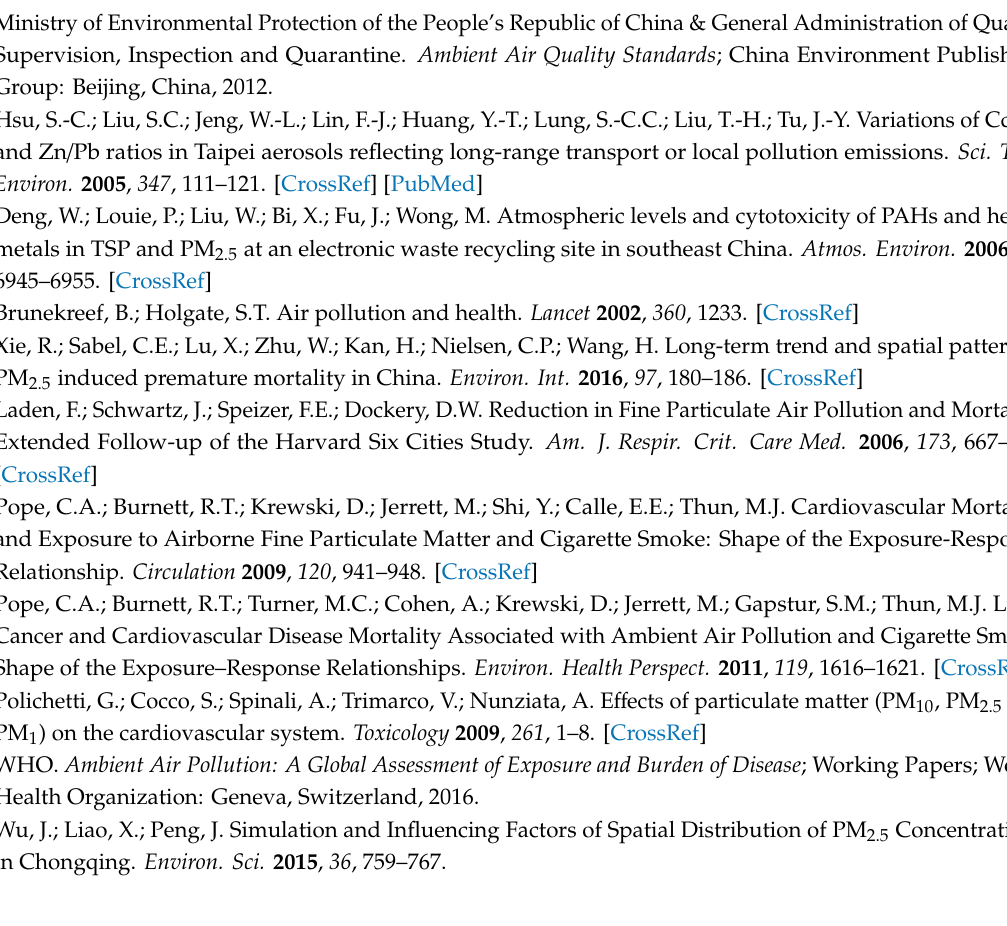
Figure S1: The map of Bohai Rim Economic Circle, Figure S2. The principle of geographical detector, Figure S3. Remote sensing images of cultivated land of the study area in di ff erent time, Figure S4. Map of the agricultural information. Chinese Agricultural Natural Regionalization shows in (a); Chinese Land Use Data shows in (b); Chinese farmland ripening data shows in (c), Figure S5. The population density map in BTH region, Table S1. Concentration limit standard of PM 2.5 , Table S2. The proportion of concentration intervals at stations and cities of BTH from 2013–2018, Table S3. The interpretation of detection indices, Table S4. Interactive detection results of PM 2.5 for BTH from 2013–2017, Table S5. Main legislations and policies on air protection adopted in China, particularly in the BTH